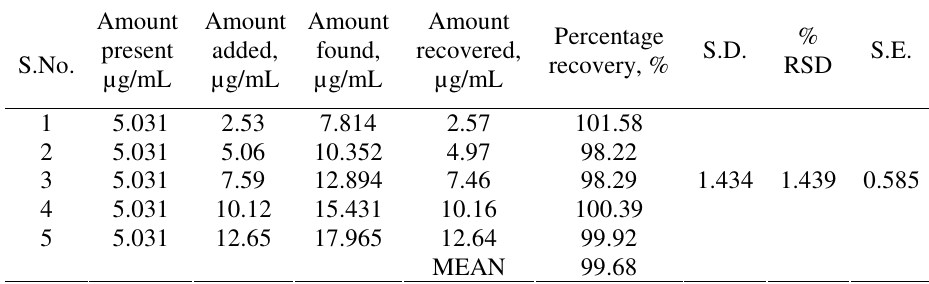
Table 4. Recovery